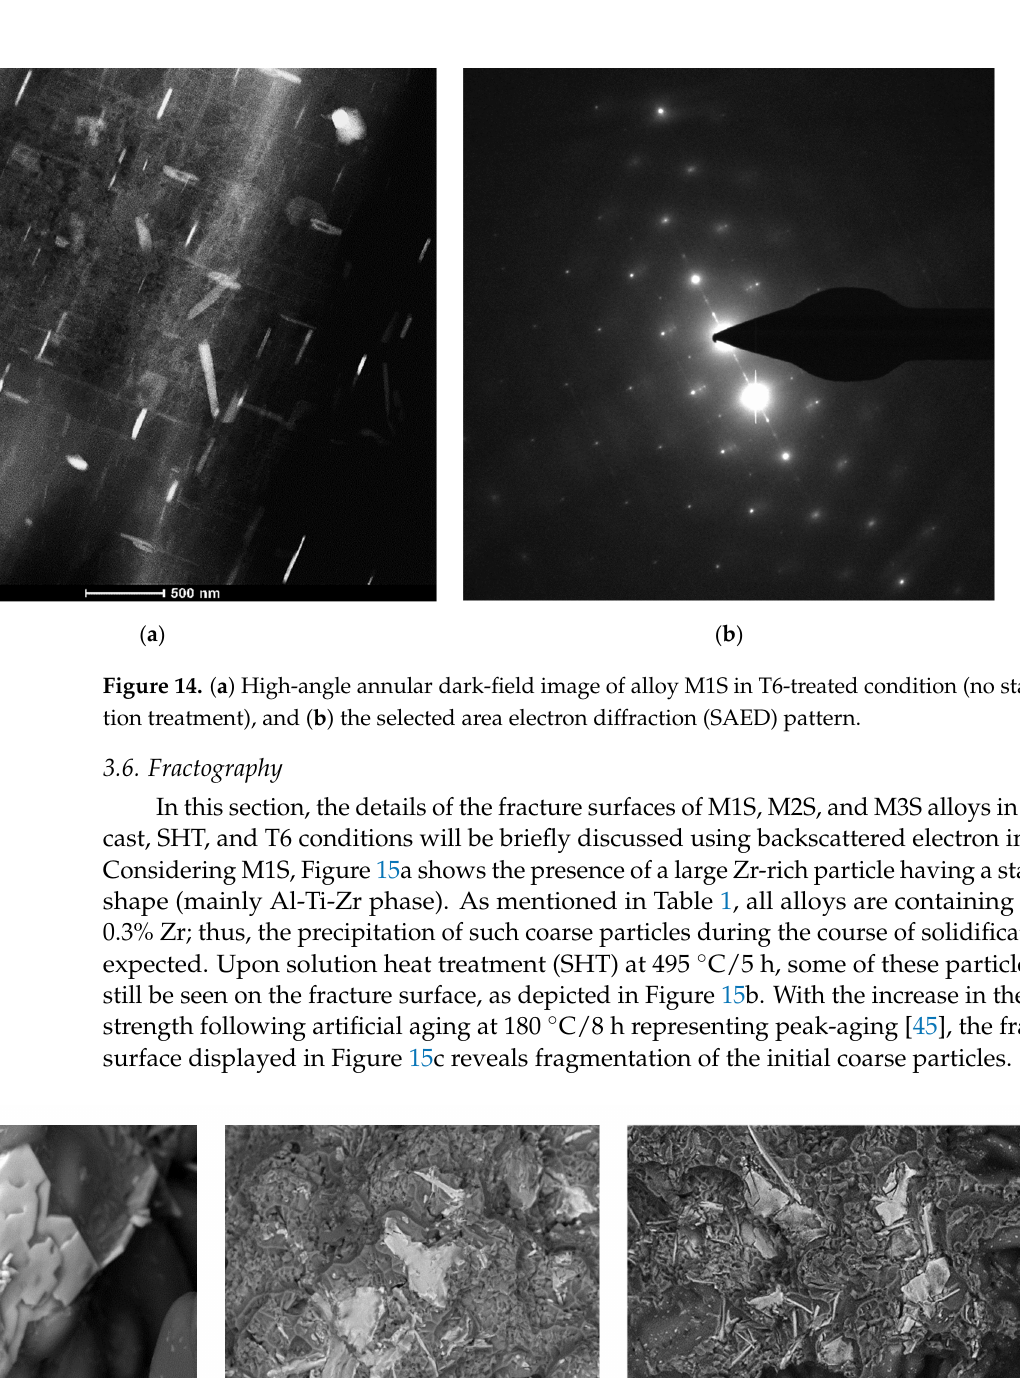
Figure 13. Bright field TEM images of precipitation during heat treatment of Sr-modified M4S alloy following ( a ) solution heat treatment, ( b ) T5 temper, ( c ) T6 + 8 h/250 °C, ( d ) T6 + 200 h/250 °C. Note the progress in the size and density of precipitated phase particles (Al 2 Cu) on going from one treat- ment to another.